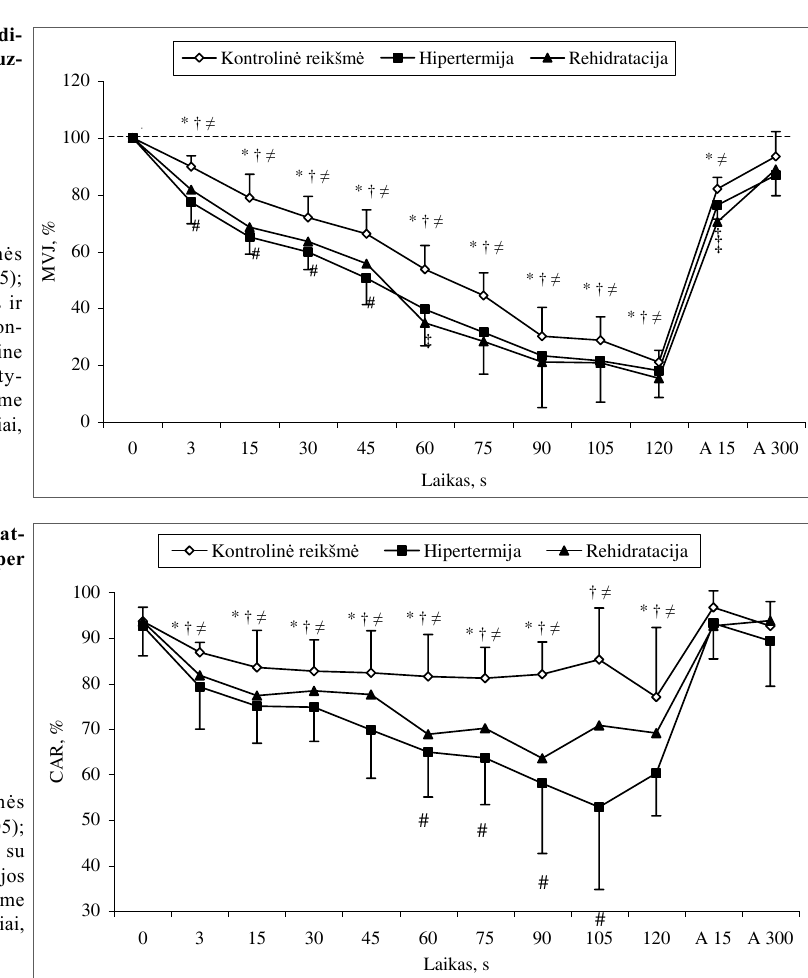
* — kontrolinio tyrimo rodikliai, lyginant su pradine reikšme (p < 0,05); ≠ — hipertermijos tyrimo rodikliai, lyginant su pradine reikšme (p < 0,05); † — rehidratacijos tyrimo rodikliai, lyginant su pradine reikšme (p <